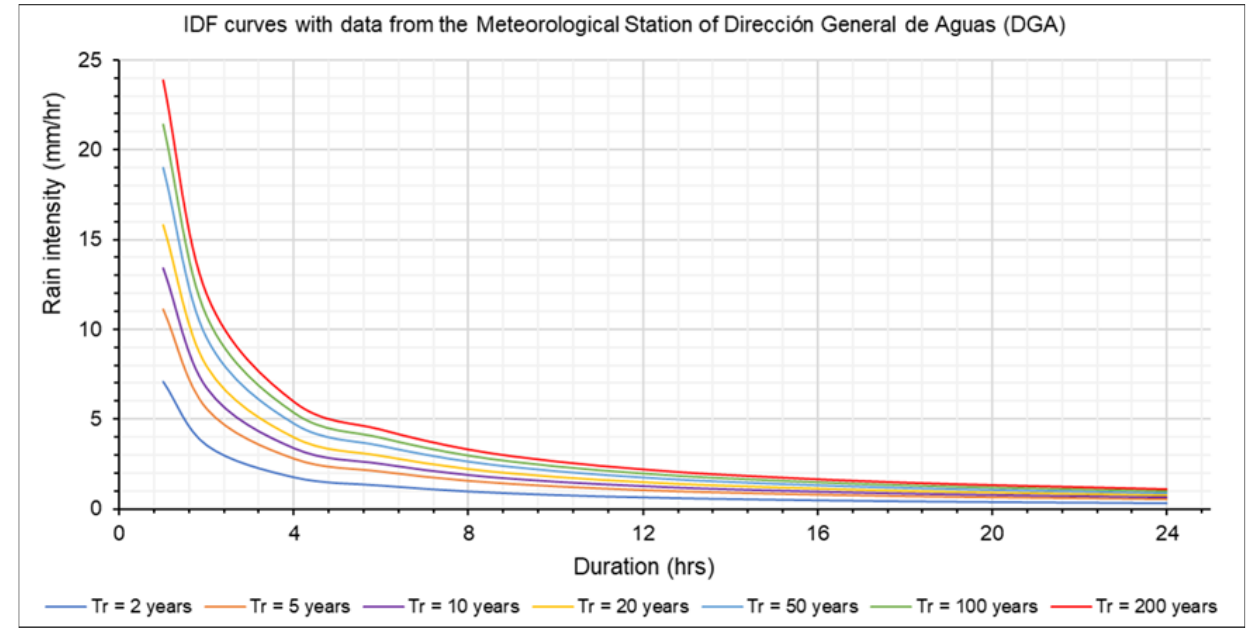
Figure 5. Intensity-duration-frequency curves (IDF) based on the record of historical and current rainfall in Antofagasta city, as recommended for this type of analysis [40]. There is constructed the debris flow hydrograph considered for the basin mouth area. For this, the volumetric concentration parameters, concentration times, runoff coefficient, and liquid and debris flows were determined for La Chimba and Guanaco sub-basin, respectively (Table 7). Table 7. Design rainfall intensity (mm/h) and debris flows (m 3 /s) as a function of concentration time ( T c ) (h) in the basin.